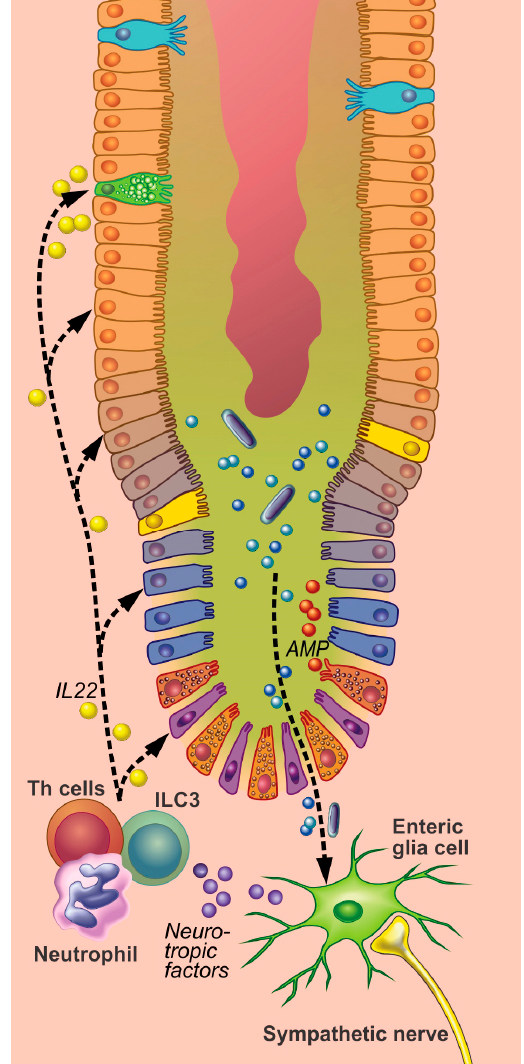
Figure 5. Inflammatory processes in the intestinal crypt. In inflammatory state, enteric glia cells are activated by proinflammatory cytokines and factors like antimicrobial peptides. Under the influence of the sympathetic neural activity neurotrophic factors are produced and extruded.